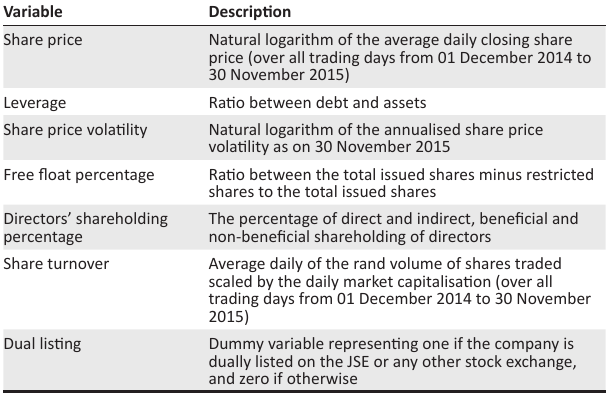
TABLE 2: Independent variables used to explain information asymmetry: Description.